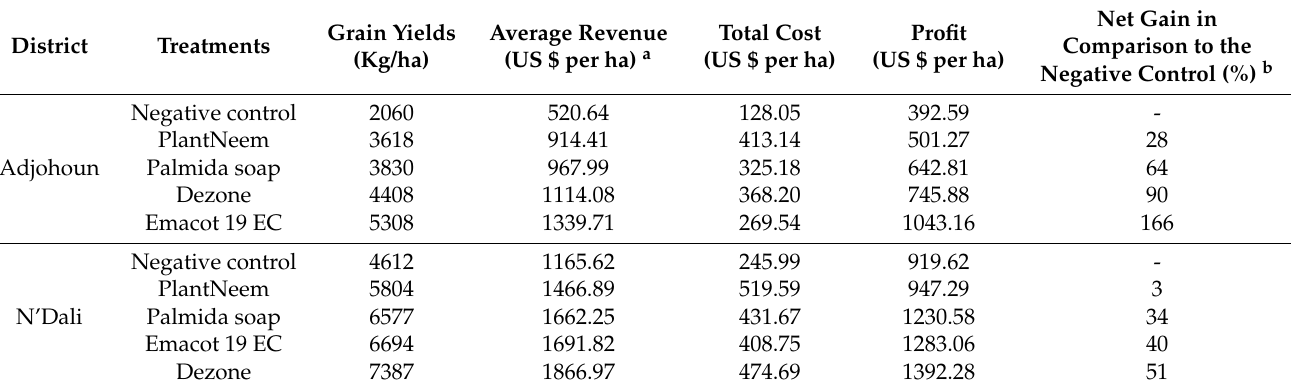
Table 6. Profitability of different FAW control strategies in maize